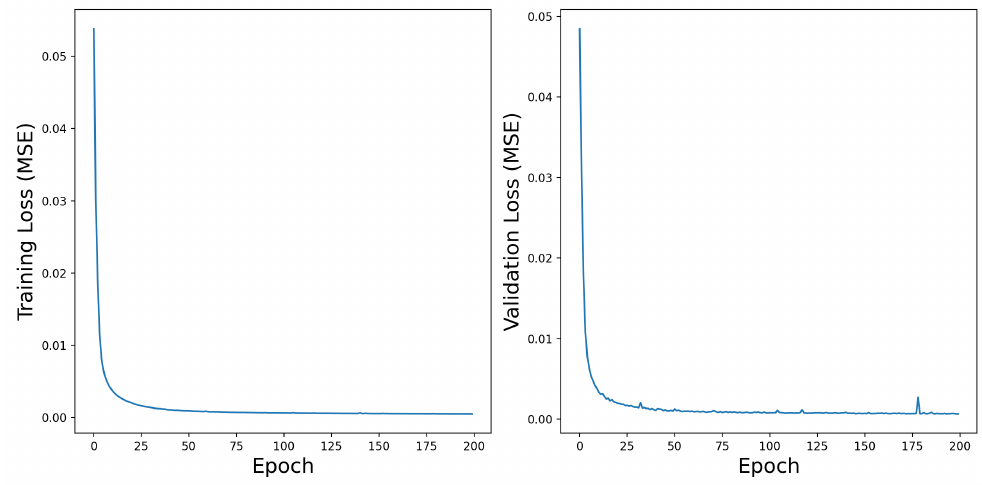
Figure 6. Training history of the proposed convolutional